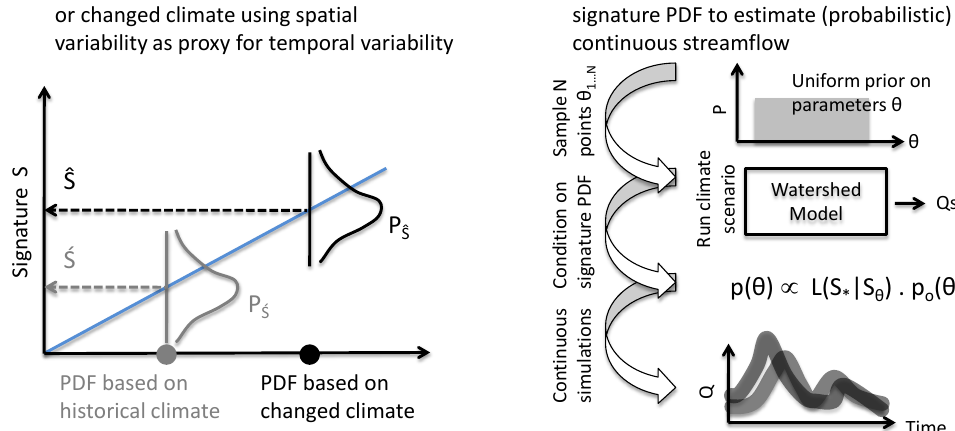
correspond to the distribution based on historical climate and ˆ S and S